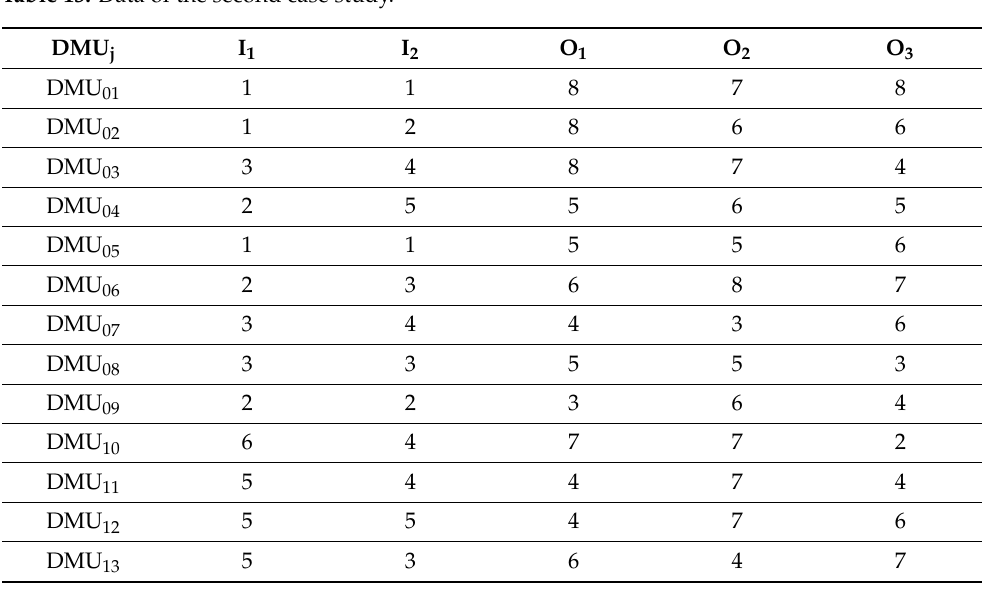
Table 13. Data of the second case